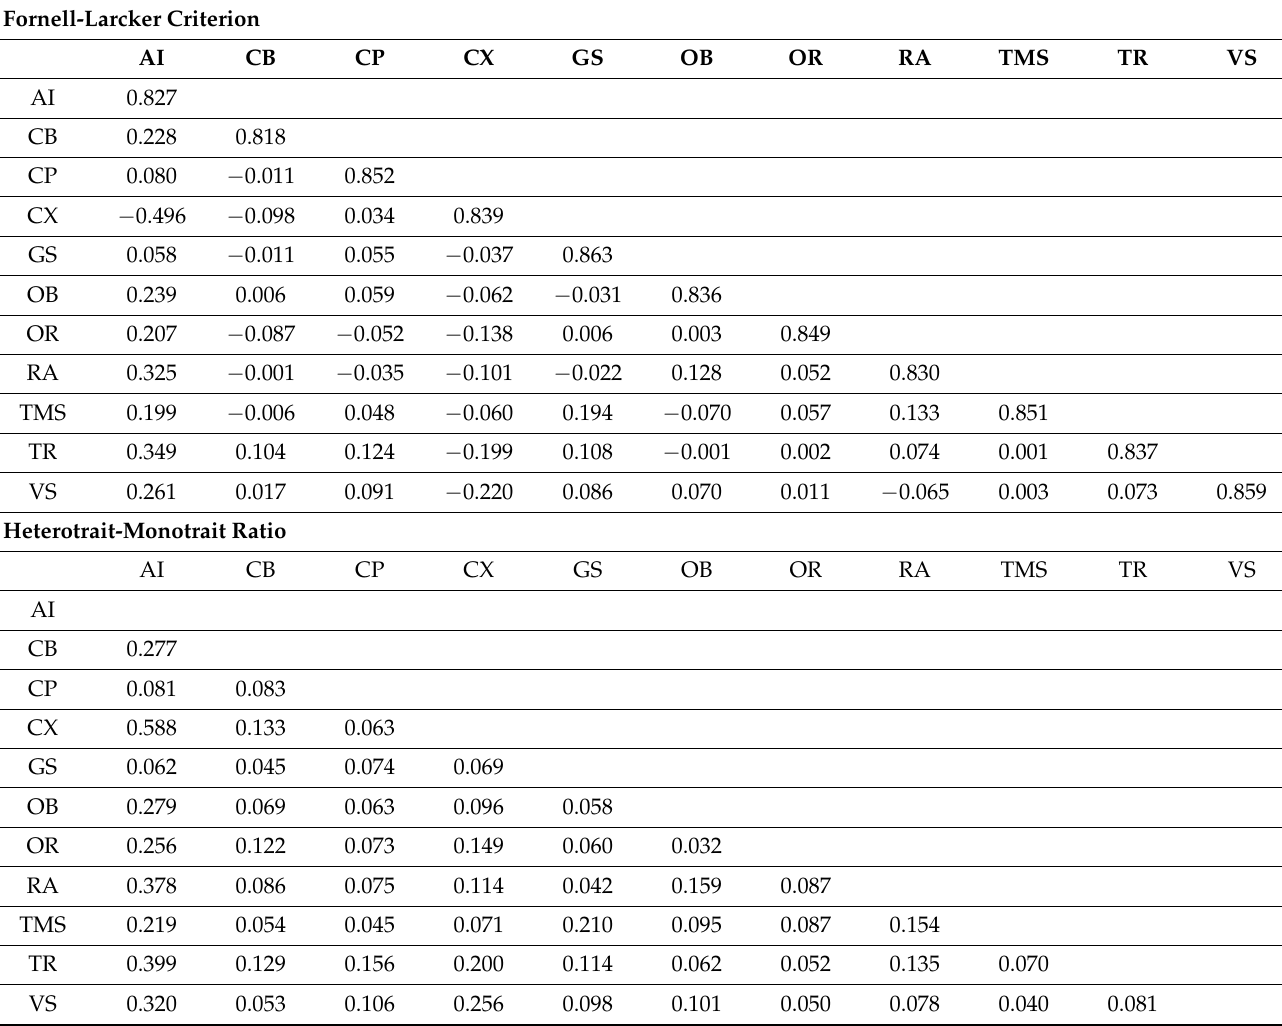
Table 3. Discriminant Validity.